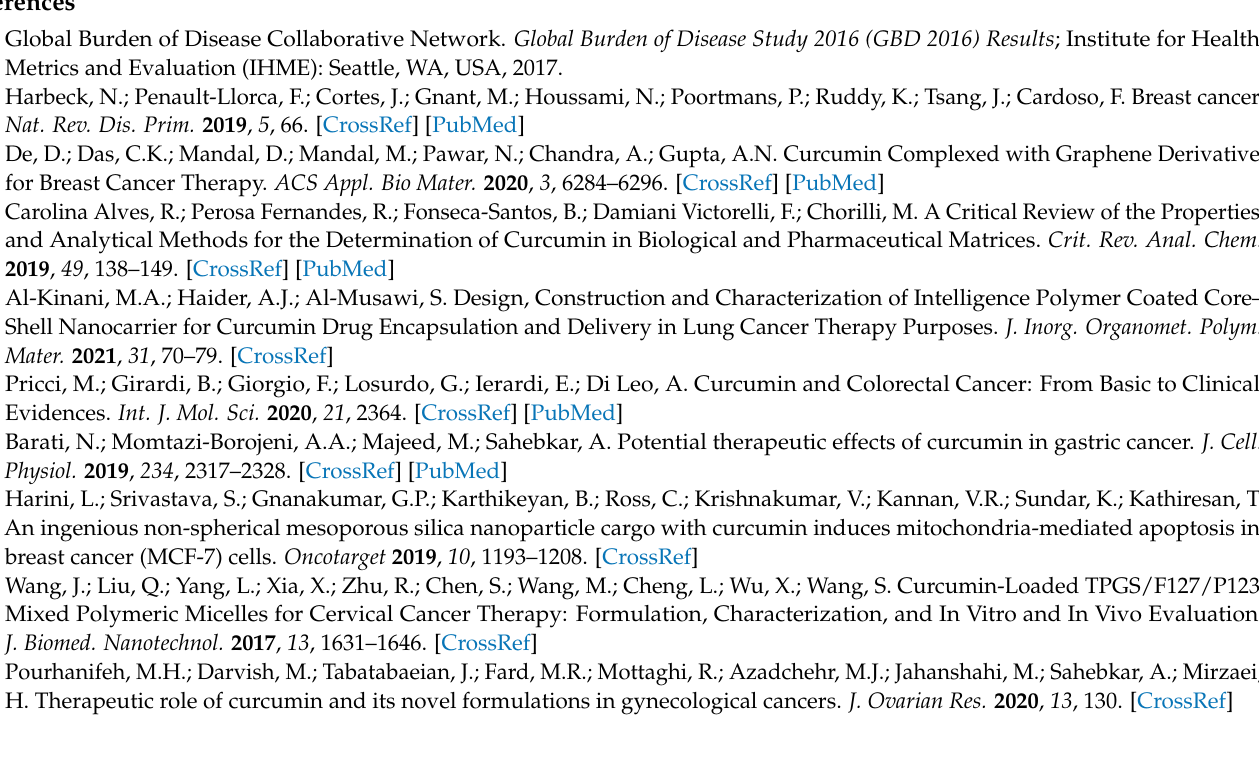
CCM in methanol solution obtained by the chromatographic method, Figure S2: Optical polarized light microscopy of the solvated compounds: (A) bioMOF-100, (B) RCA, Figure S3: TGA-DSC curves of the RCA compound, Figure S4: Simulated crystalline structure of BioMOF-100, which has 85.5% voids/cell. The probe used consisted of a spherical molecule of H2(g), containing 1.2 Å radius, Figure S5: (a–b) accessible cavities referring to the existing solvent channels along the crystallographic direction [110], Figure S6: TG-DSC curves of the CCM@RCA-1D compound, Figure S7: Analytical curves of CCM in receptor medium obtained by the chromatographic method: (A) at pH = 5.0 and (B) at pH = 7.4, Table S1: Probability level relationship, conformer identification, and RMSD, Table S2: Percentage of CCM released from samples after 132 h of the